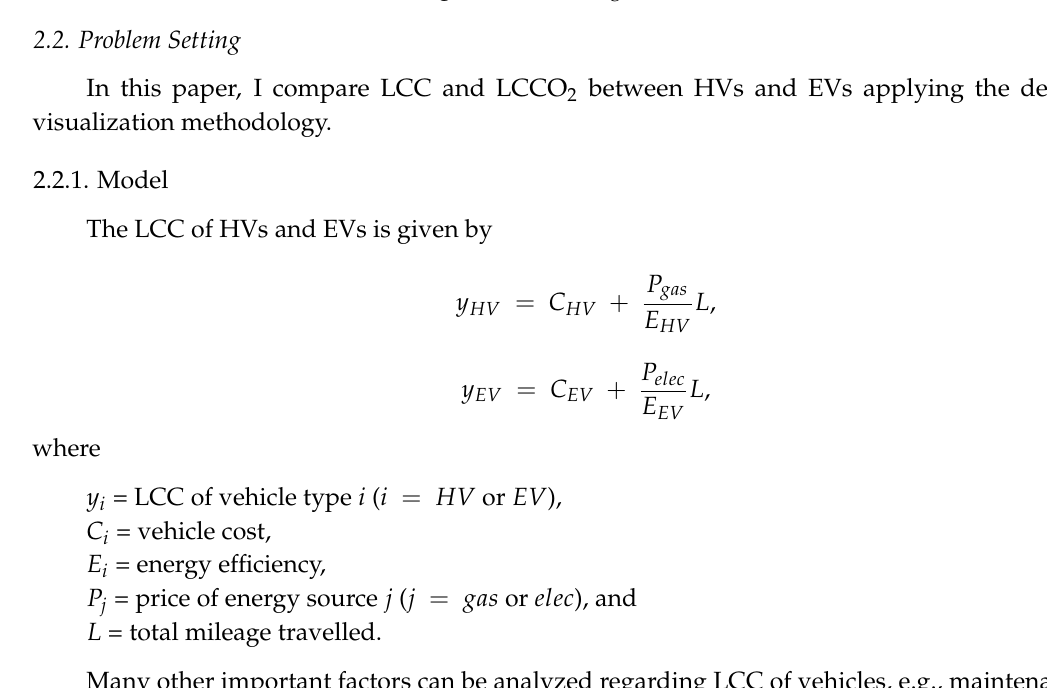
Figure 2. Phase diagram of water.